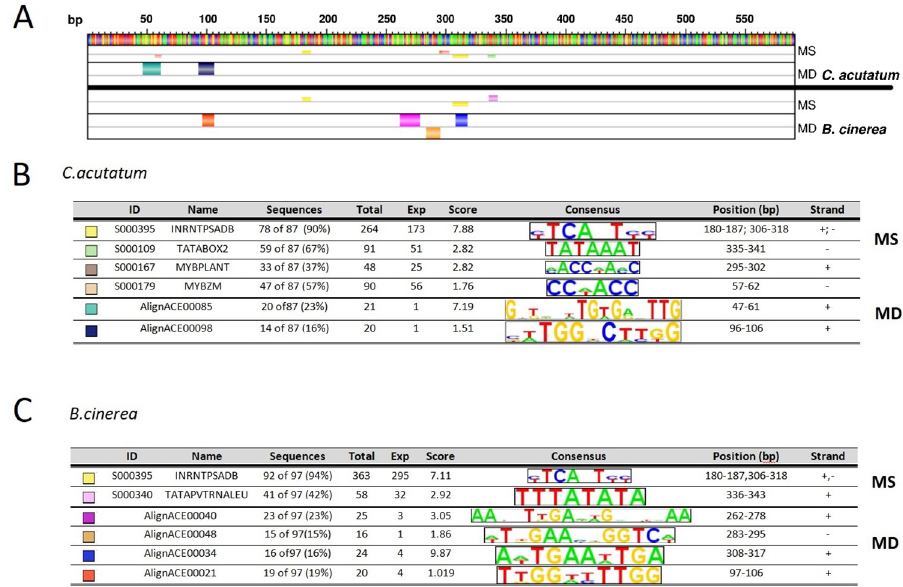
Fig 5. In silico analysis of predicted regulatory elements in pathogen-induced fragaria genes. (A) From the top: FveRALF3 gene putative promoter, Motif Scanning (MS) and Motif Discovery (MD) outputs resulting from the analyses of C . acutatum- induced genes, and MS and MD outputs from the analysis of B . cinerea- induced genes 24 h post-infection. Small colored boxes in MS indicate known regulatory elements from PLACE database found to be significantly abundant in the group of sequences analyzed and in FveRALF3 putative promoter, while large coloured boxes in MD represent sequences found significantly enriched in the upstream sequences of genes analyzed. (B) and (C) are the color key respectively for C . acutatum and B . cinerea reported in (A). Codes and names of regulatory elements are reported, together with elements percentage abundance among sequences analyzed (Sequences), total count of elements found (total), element background frequency calculated as number of elements found in a third order random generated sequences (Exp), ranking score values calculated by MotifLab software using a binomial test with p-value threshold of 0.05 (Score). Consensus sequence of each element is shown along the position of the element in the putative FveRALF3 promoter (Position bp) and the strand in which it is